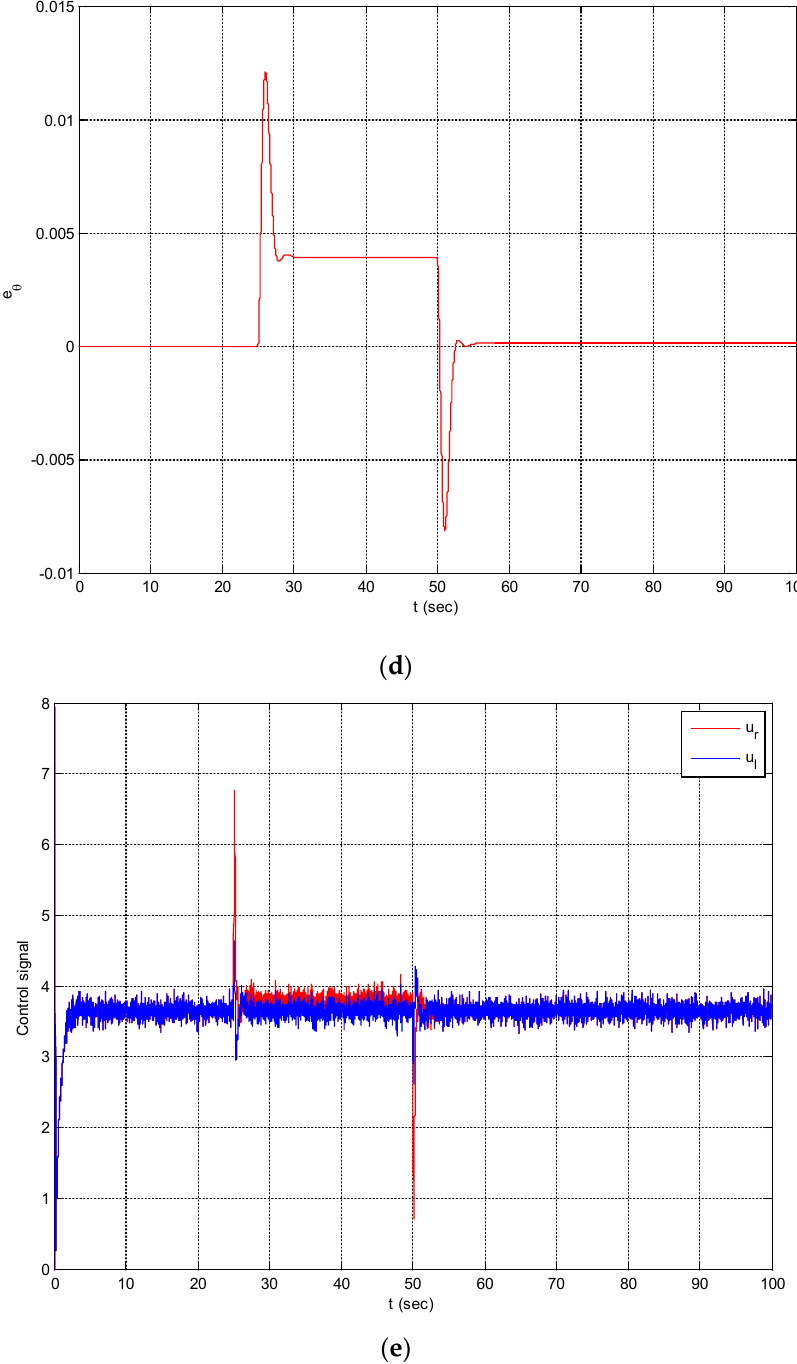
Figure 7. Output results for LESO, ( a ) The right wheel angular velocity, ( b ) close-up of ( a ), ( c ) The left wheel angular velocity, ( d ) the orientation error of the DDMR, and ( e ) the control signal.